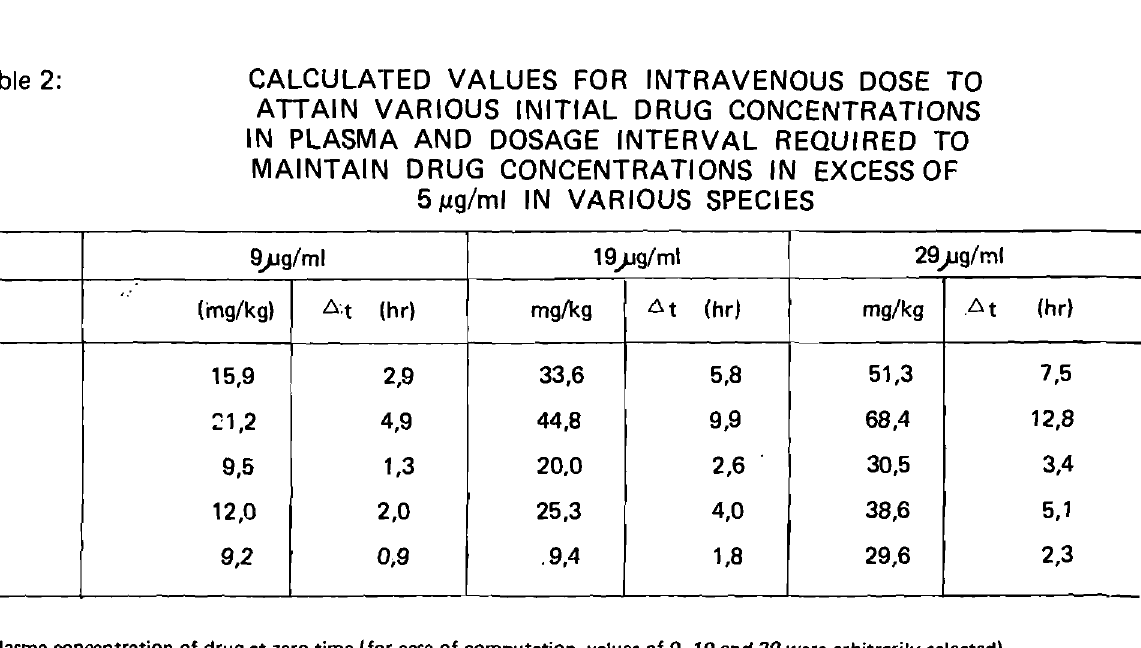
Co Plasma concentration of drug at zero time (for ease of computation, values of 9,19 and 29 were arbitrarily selected). Dose amount of drug necessary to produce the given initial drug concentration. ~ t interval between doses which would be just sufficient to maintain blood concentratiOns of drugs in excess of 5 'J.Ig/ml.